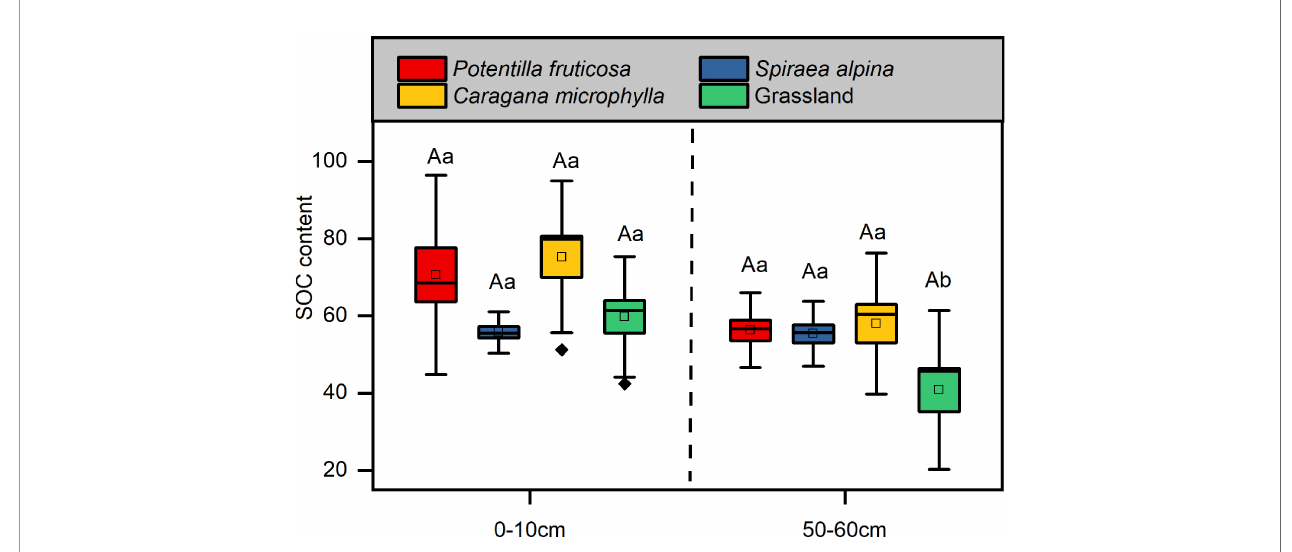
FIGURE 3 | Soil organic content. Different lowercase letters indicate signi fi cant differences between the different soil layers within the same vegetation types ( p < 0.05, independent-samples t-test). Different uppercase letters indicate signi fi cant differences between the different vegetation types within the same soil layers ( p < 0.05, Tukey ’ s HSD test).